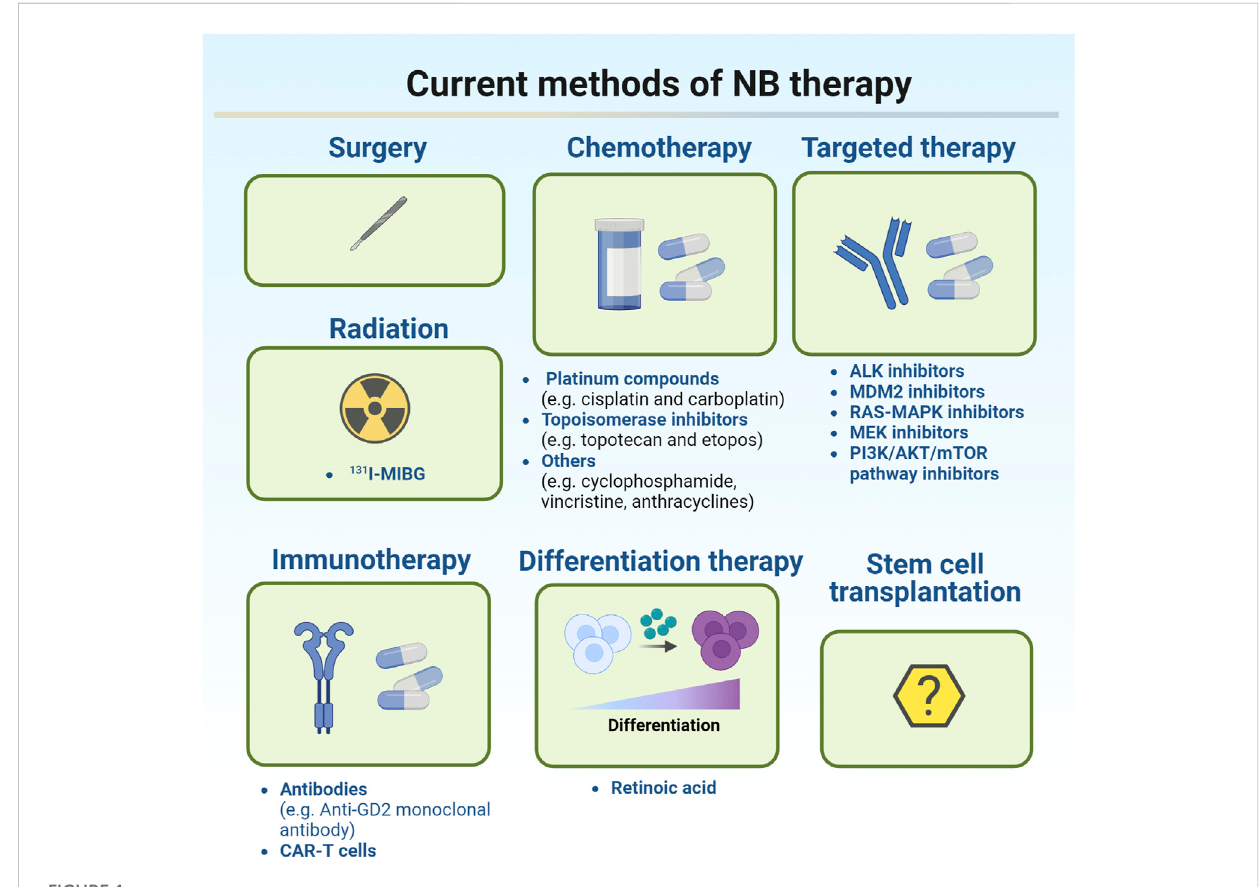
FIGURE 1 Current methods of NB